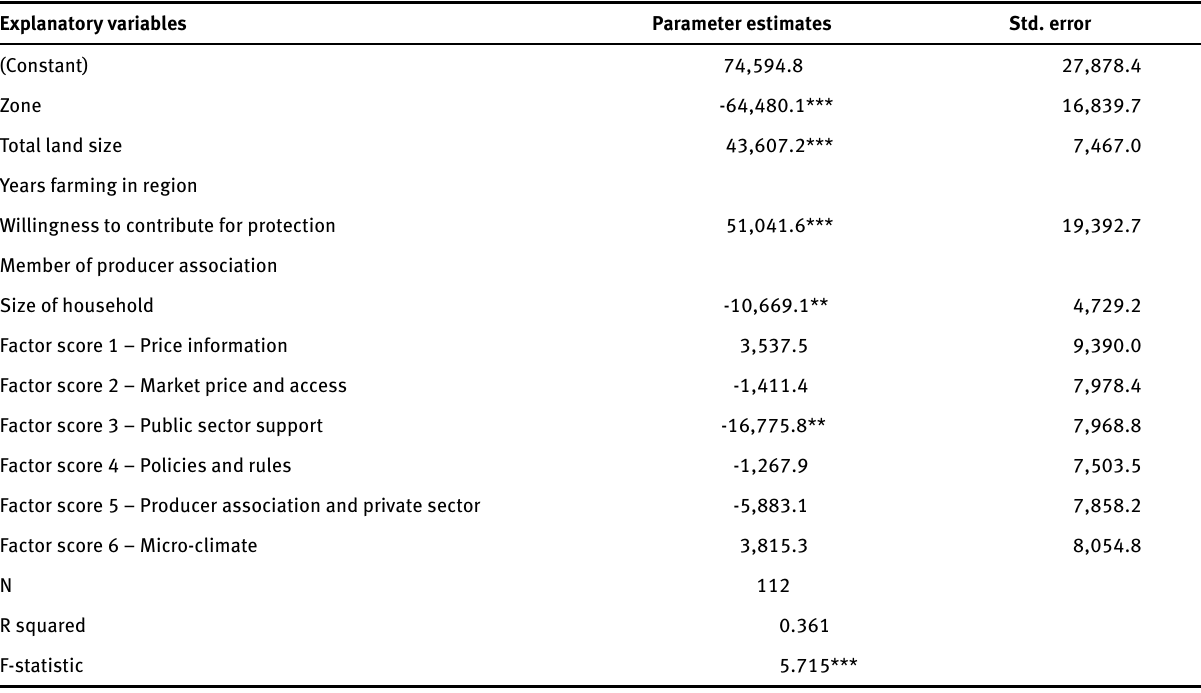
Table 4: Regression parameter estimates for tea producers’ profit Explanatory